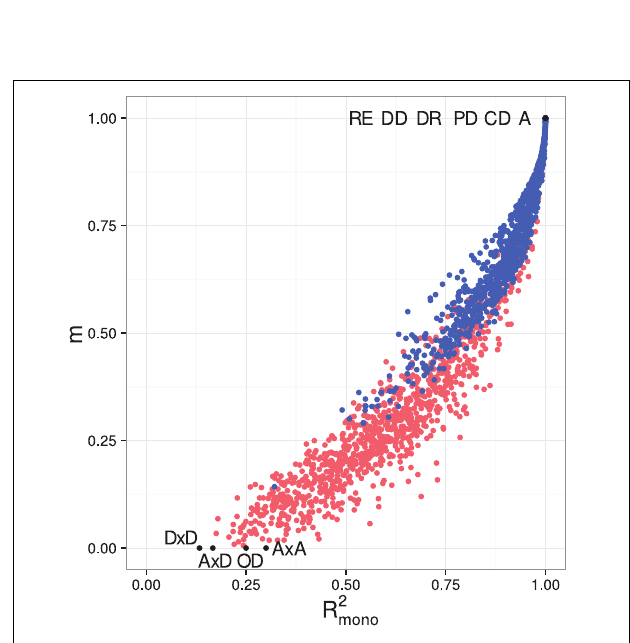
FIGURE A2 | Comparing measures of monotonicity GP maps. Scatterplots showing degree of monotonicity ( m ) vs. R 2 mono . Black dots correspond to the maps shown in Figure 1 . Red dots show 1000 random two-locus GP maps, while blue dots show the same 1000 GP maps after sorting to introduce order-preservation for 1 locus [see Model and Methods in Gjuvsland et al.